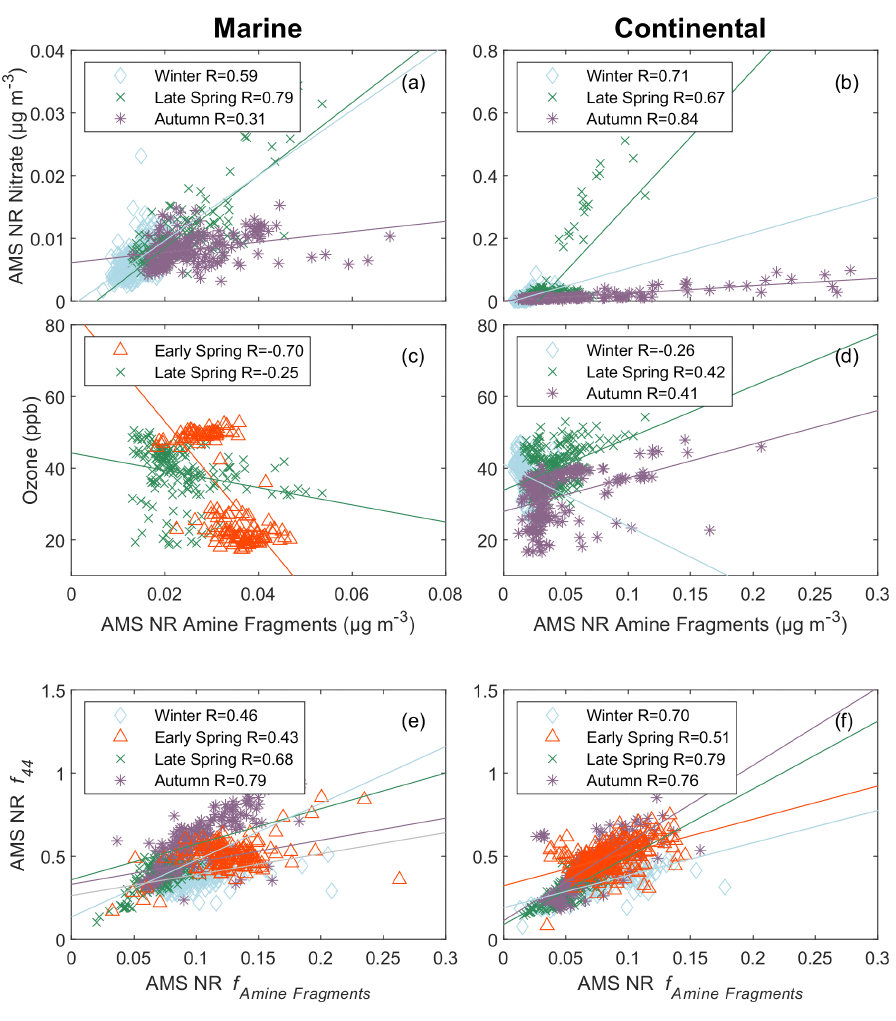
Figure 5. Scatterplot of secondary tracers versus AMS NR amine fragments for marine periods (a, c, e) and continental periods (b, d, f) . The panels include submicron AMS NR nitrate (a, b) , ozone (c, d) , and AMS NR m/z 44 (e, f) . Markers represent each cruise: blue open diamond – winter, green cross – late spring, purple asterisk – autumn, and red open triangle – early spring. The solid lines are the lines of best fit obtained using an ordinary least squares regression for R | ≥ 0 .